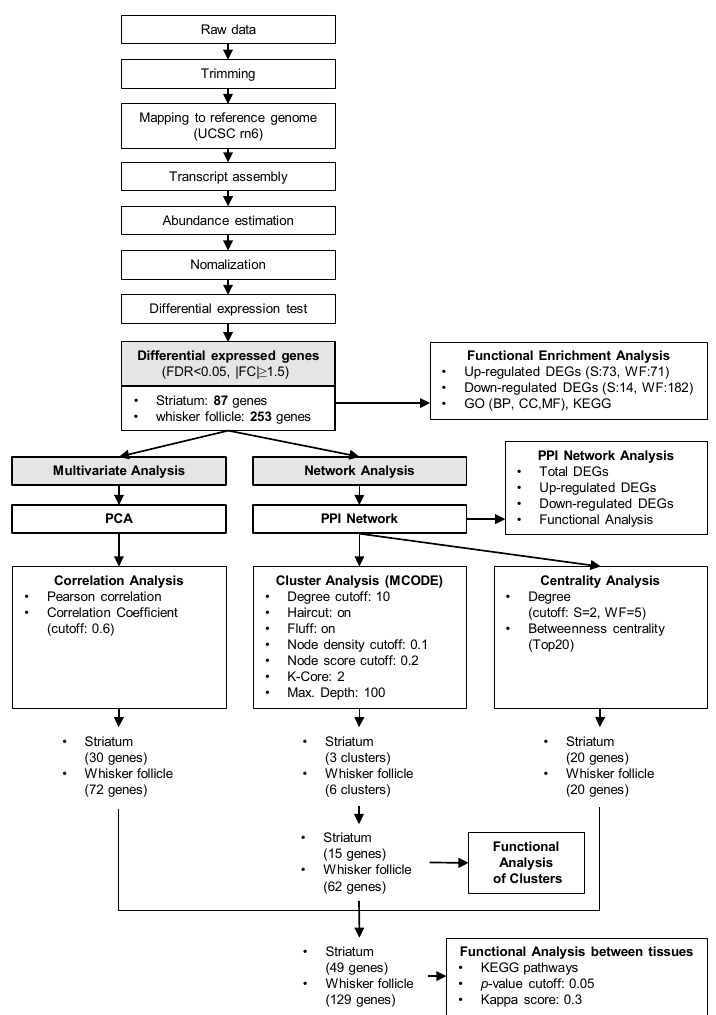
Figure 2. The workflow of computational analysis of the RNA sequencing (RNA-seq) data. A workflow diagram for the quality control and di ff erential gene expression analysis of the RNA-seq data from the striatum or from the whisker follicle of MA self-administered